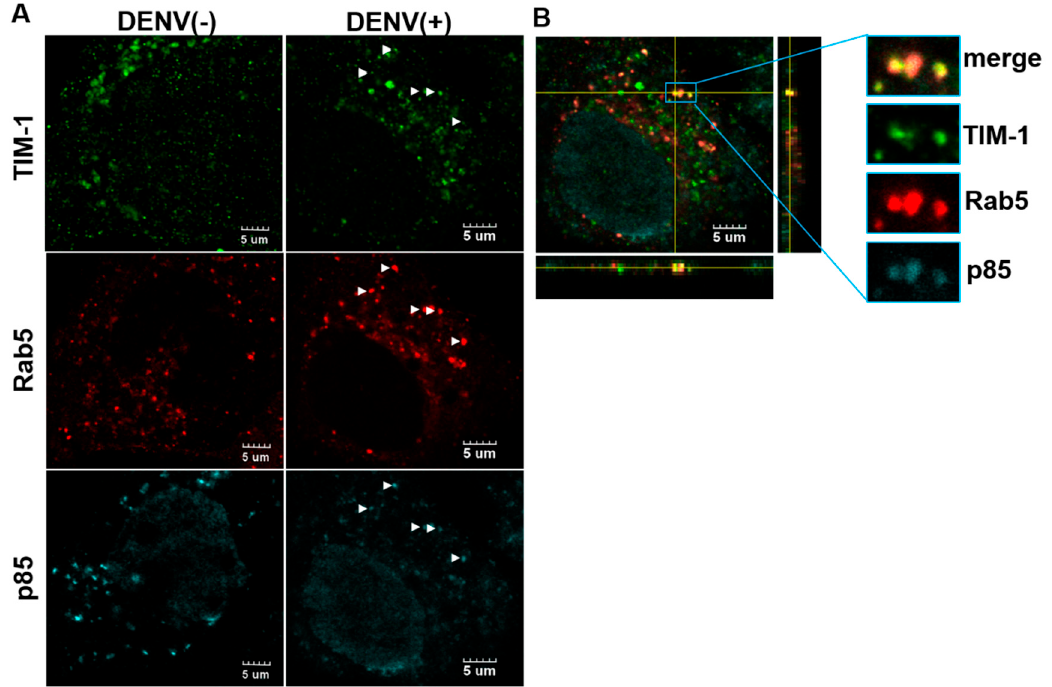
Figure 4. The colocalization of TIM-1 with p85 at Rab5-positive endosomes by DENV infection. ( A ) The cellular location of TIM-1 (green), p85 (cyan), and Rab5-positive endosome (red) were visualized in Huh7.5 cells transfected with a Rab5-DsRed plasmid in the absence or presence of DENV infection at a MOI of 10 for 30 min post-infection. Fluorescence images were acquired using an Olympus FluoView 1000 confocal microscopy. White arrowhead indicated triple-colocalization. The scale bar represents 5 μ m. ( B ) The three-dimensional reconstruction of the Z-stacked deconvolved image showed the colocalization of TIM-1 with p85 at Rab5-positive endosomes. In fluorescence intensity profiling, the signal distribution of TIM-1, p85 and Rab5-positive endosomes were indicated in green, cyan, and red, respectively.